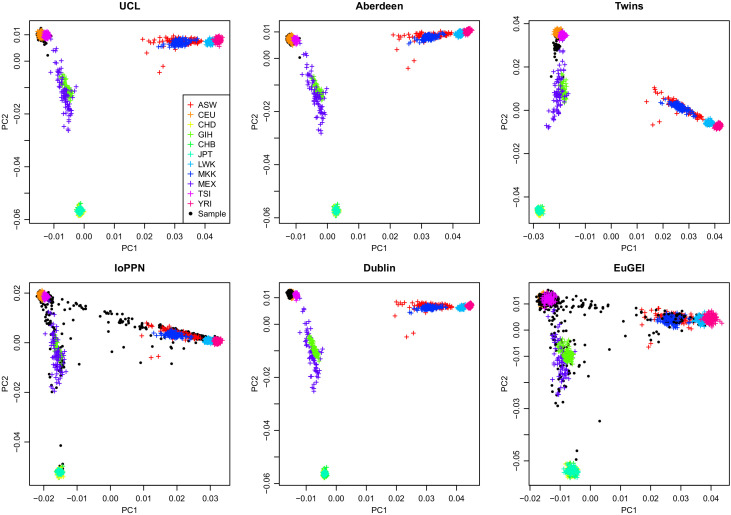
Scatterplot of the relationship between the first two genetic principal components merged with HapMap phase 3 data for individual cohorts.With the exception of the IoPPN and EUGEI cohorts, there is little ethnic heterogeneity in each of the cohorts with samples being predominantly of Caucasian origin.